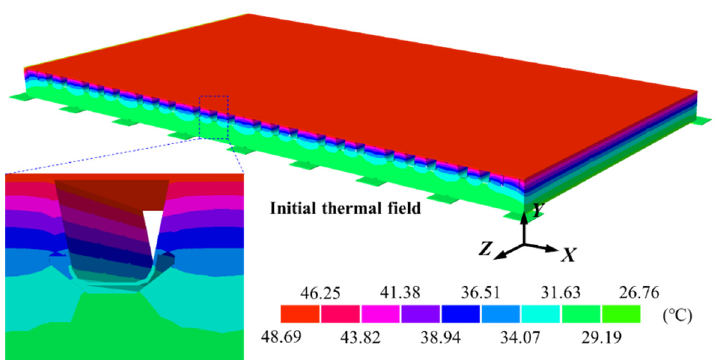
Figure 9. Initial thermal field of OSD before PGA paving. Table 2. Comparison of initial temperatures based on monitoring and numerical results. Measuring Point